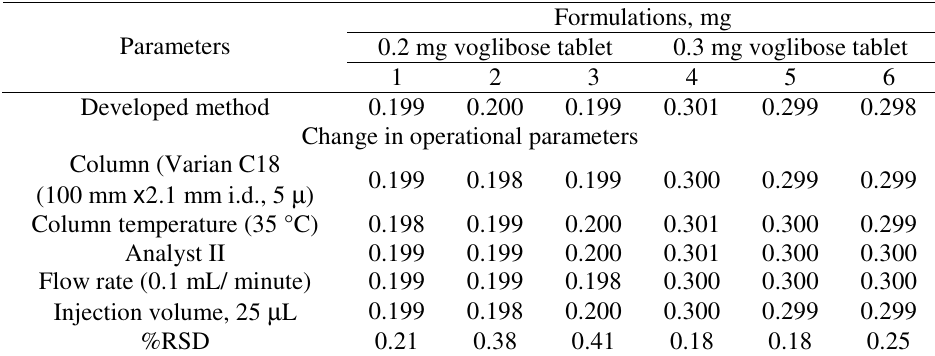
Table 6. Data for the robustness studies for voglibose content in formulation by LC-MS/MS (sample analyzed in triplicate under changed